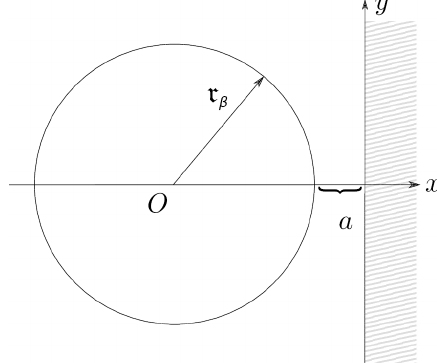
Figure 13. Sketch of the setup for calculating the binding energy between two axially symmetric N -Skyrmions. The radius containing most of the energy of the baby Skyrmion is r β with a suitable value for β (i.e. the fraction of the BPS energy density contained within the radius); here we shall √ use r 1 . 517 2 N . The separation between the two baby Skyrmions is 2 a and the gluing 0 . 99 ’ boundary conditions in the problem are imposed at x = x 1 = 0 (i.e. the y -axis in the